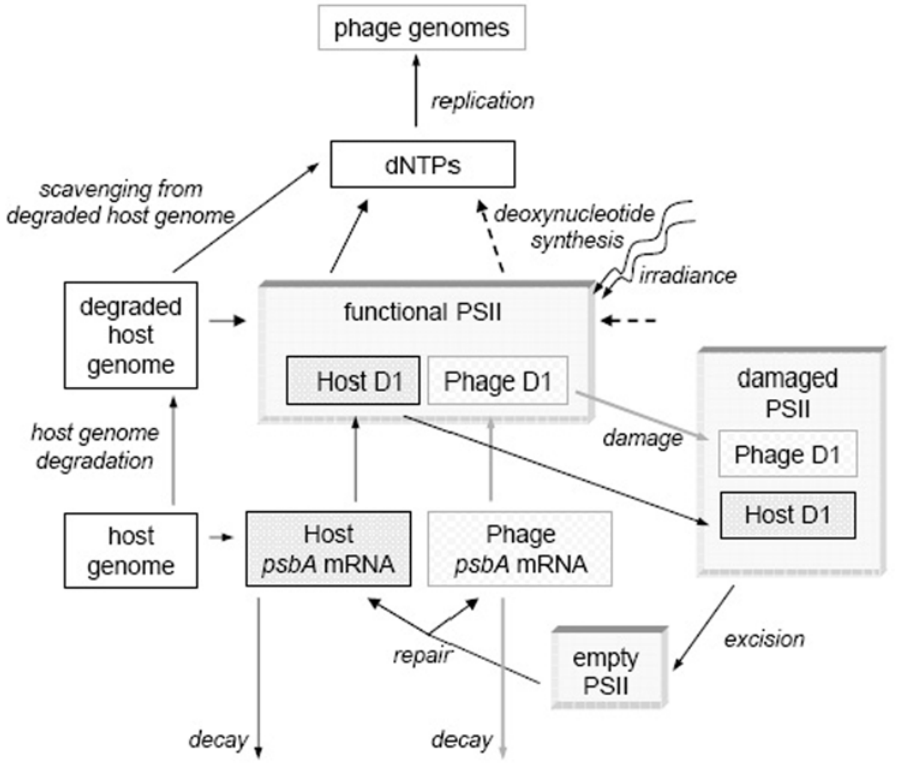
Figure 1. Schematic diagram of model. Phage genomes are made using dNTPs from two possible sources. First, dNTPs can be made by scavenging deoxynucleotides from the host genome. This process can occur in the dark, but is bolstered by photosynthesis. Second, dNTPs can be newly synthesized by a process that is dependent on the products of photosynthesis (dashed lines). Photosynthesis is dependent on functional PSII subunits, which contain the D1 protein. During exposure to light, D1 proteins can become damaged, and are excised from PSII subunits, and replaced with D1 proteins from either host or phage encoded psbA mRNAs.